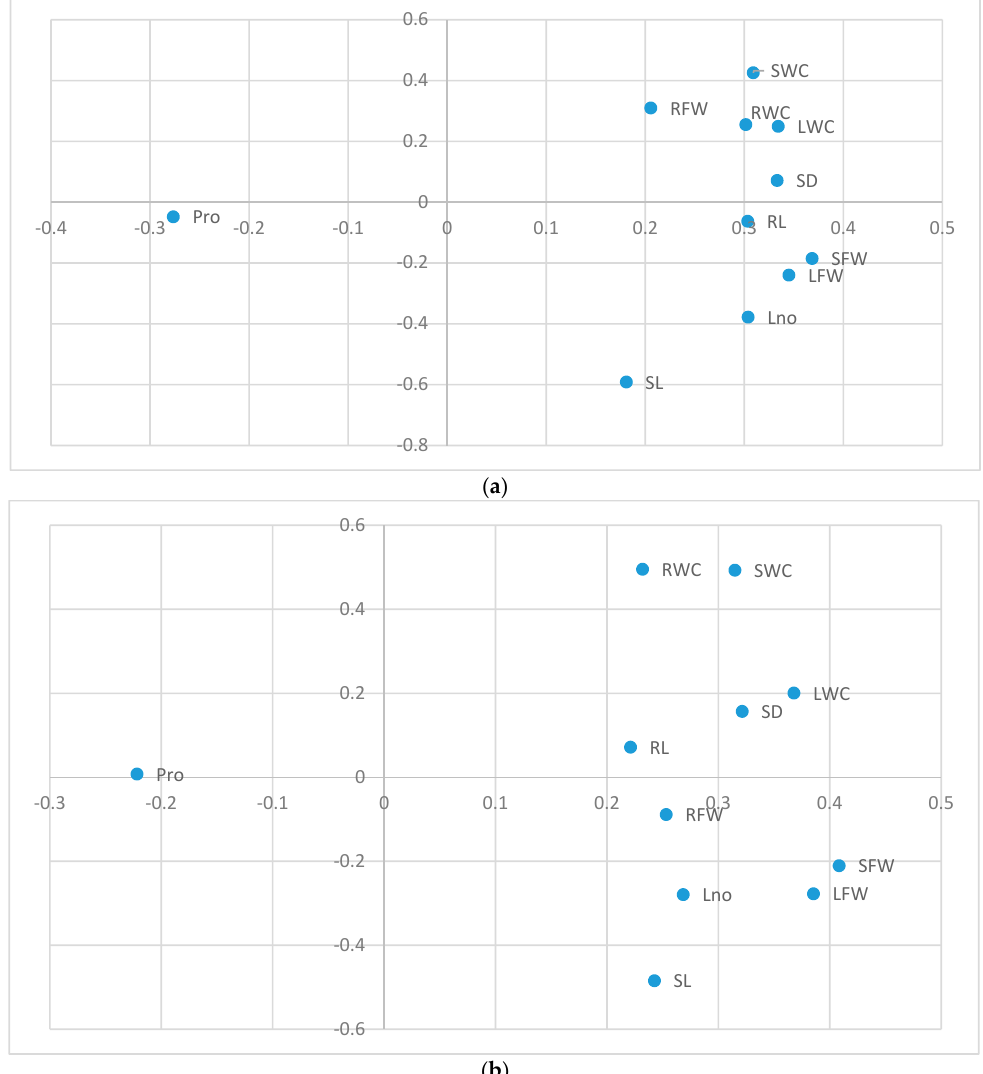
Figure 2. Loading plot of the principal component analysis (PCA) conducted with the analysed traits, in P. vulgaris cultivars subjected to control, water deficit and salt stress treatments. Two-week treatments ( a ); 56.5% and 13.6% of the total variability are explained by the first ( x -axis) and the second ( y -axis) components, respectively. Three-week treatments ( b ); 44.3% and 14.0% of the total variability are explained by the first ( x -axis) and the second ( y -axis) components, respectively. Abbreviations: RL, root length; RFW, root fresh weight; RWC, root water content; SD, stem diameter; SL, stem length; SFW, stem fresh weight; SWC, stem water content; Lno, leaf number; LFW, leaf fresh weight; LWC, leaf water content; Pro, proline. The 18 cultivars from the shorter treatment period (Figure 3a) were dispersed onto the two axes of the scatterplot, indicating high variability in the selected genotypes. There was, however, good separation between the different treatments, not only when looking individually at each cultivar, but also considering the overall behaviour of all genotypes. Plants from the control (green symbols) and water stress (pink) treatments were clearly separated, with almost no overlapping between the two conditions. Those symbols (blue) corresponding to the salt stress treatments appear located in the scatterplot in-between the control and water stress samples, which was in agreement with the weaker effect (on average) of the salt treatments as compared to water deficit, under the specific